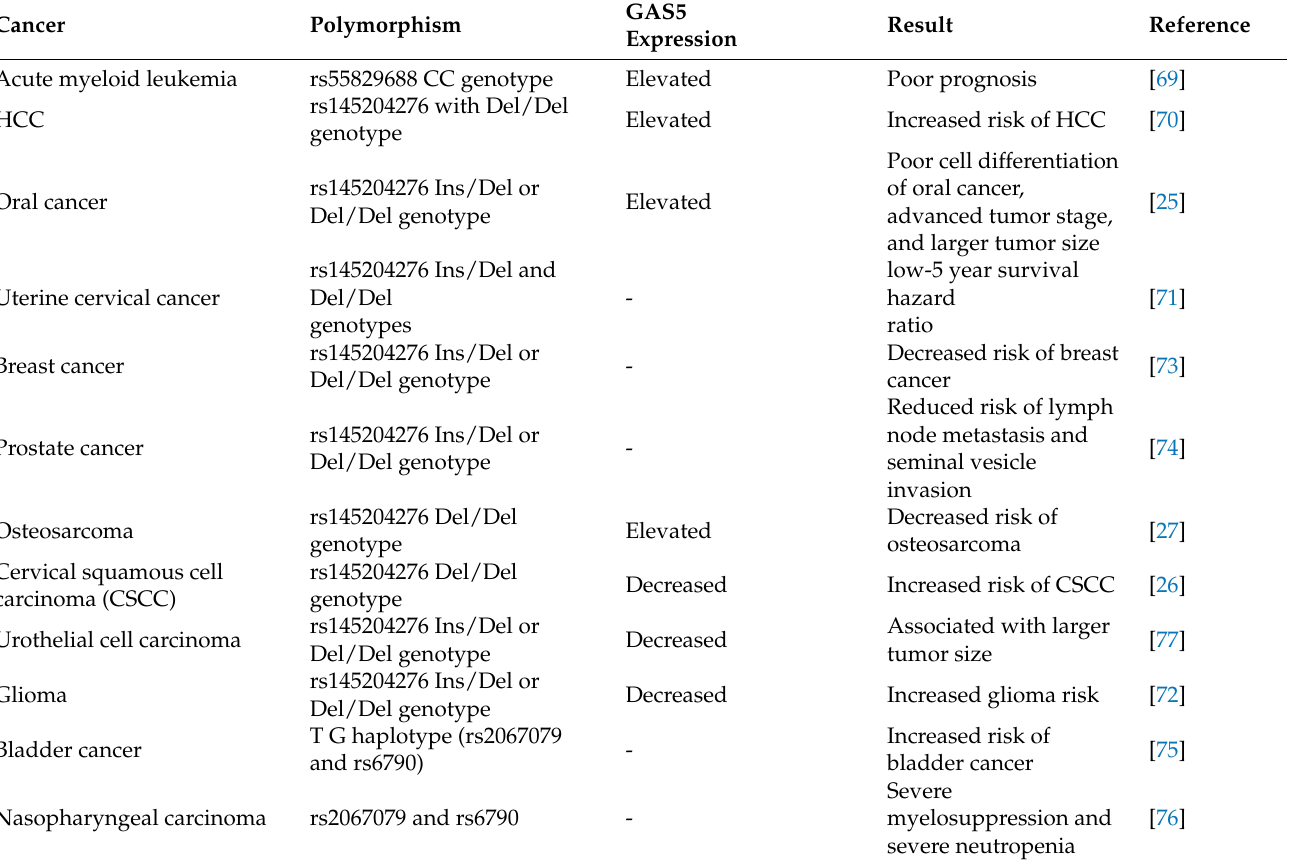
Table 2. GAS5 polymorphisms in various cancers. ‘-’ indicates that Gas5 expression is not